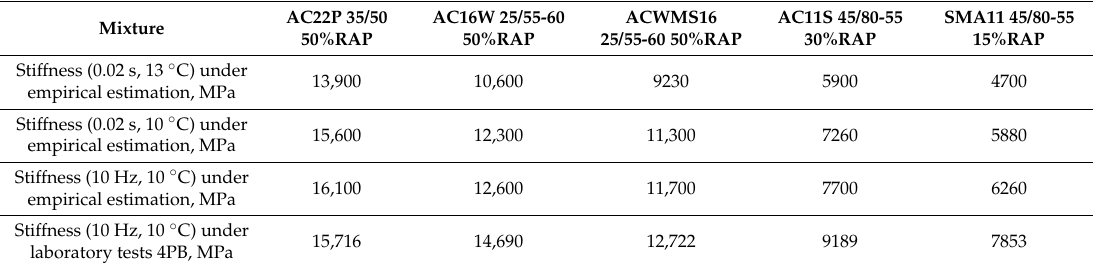
Table 3. Stiffness modulus.